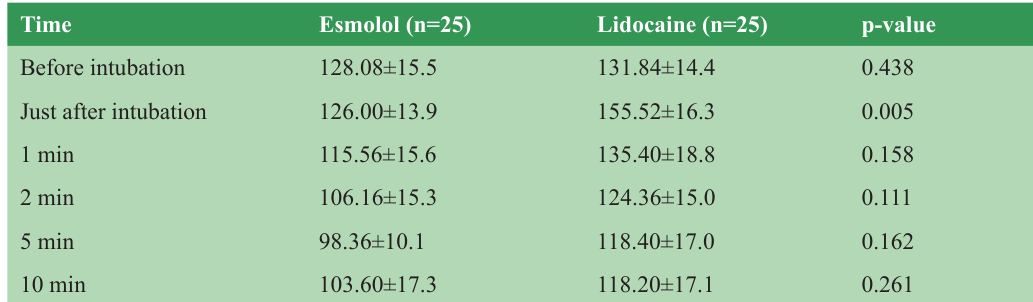
Table 4: Mean systolic blood pressure (mm Hg) between esmolol and lidocaine group Time Esmolol (n=25) Lidocaine (n=25)